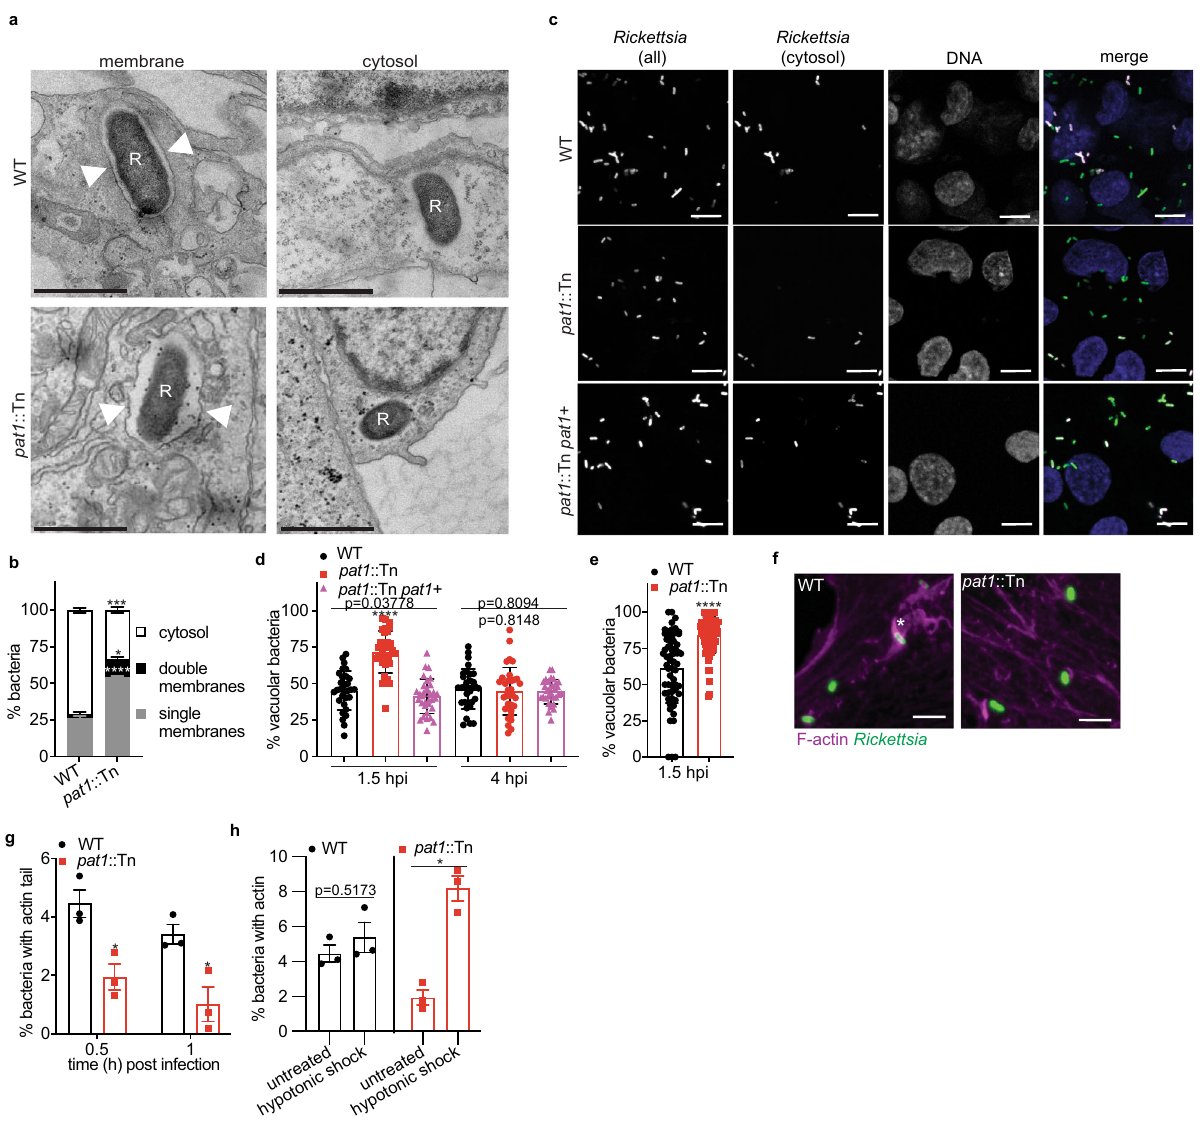
Fig. 2 Pat1 facilitates escape from single and double membrane compartments following invasion. a TEM images of WT and pat1 ::Tn mutant bacteria in HMECs at 1 hpi. “ R ” indicates R. parkeri and arrowheads point to membrane surrounding the bacteria. Scale bar 1 µ m. b quanti fi cation of ( a ), percentage of single and double membrane-bound or cytosolic bacteria ( n = 3 independent experiments, >50 bacteria quanti fi ed), MOI 5. Data are mean ± SEM ( n = 3 independent experiments); **** p < 0.0001 (single membranes) *** p = 0.0002 (cytosol) *p = 0.0115 (double membranes) relative to WT (unpaired t -test (two-tailed)). c Images of cytosolic bacteria (magenta) in HMECs infected with WT, pat1 ::Tn, or pat1 ::Tn pat1 + bacteria (green in merge) at 1.5 hpi. Scale bar 5 µ m. d Quanti fi cation of ( c ), percentage of vacuolar bacteria at 1.5 and 4 hpi in HMECs, MOI 5 ( n = 2 independent experiments; WT n = 32 fi elds (1.5 hpi), 33 fi elds (4 hpi), pat1 ::Tn n = 33 fi elds (1.5 hpi, 4 hpi), pat1 ::Tn pat1 + n = 33 fi elds (1.5 hpi), 32 fi elds (4 hpi). e Quanti fi cation of vacuolar bacteria at